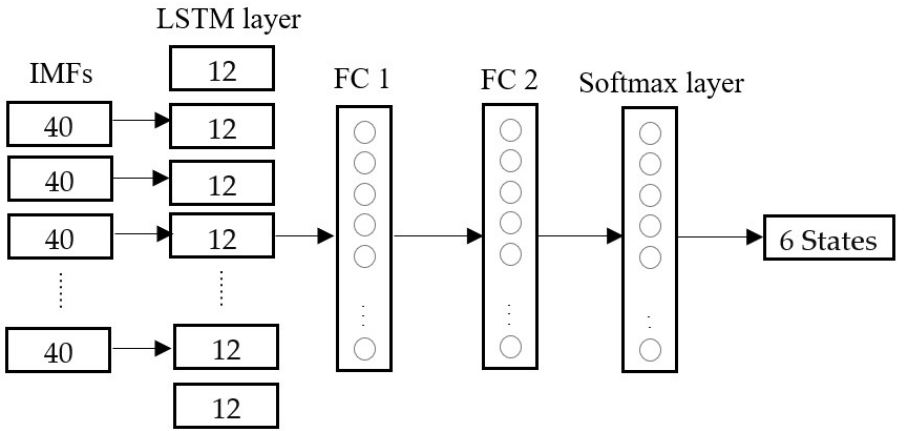
Figure 7. The structure of LSTM networks for hydraulic system fault diagnose.